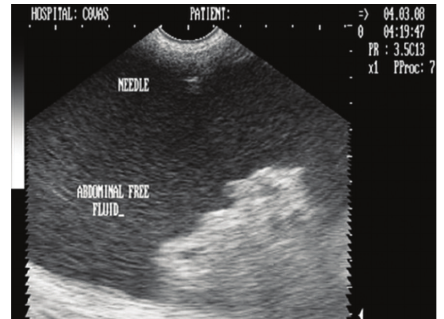
Figure 2: Two-dimensional ultrasonographic appearance of 22- gauge needle as hyperechoic structure within the textured abdom- inal e ff usion in 6-year-old male Labrador Retriever a ff ected with infectious